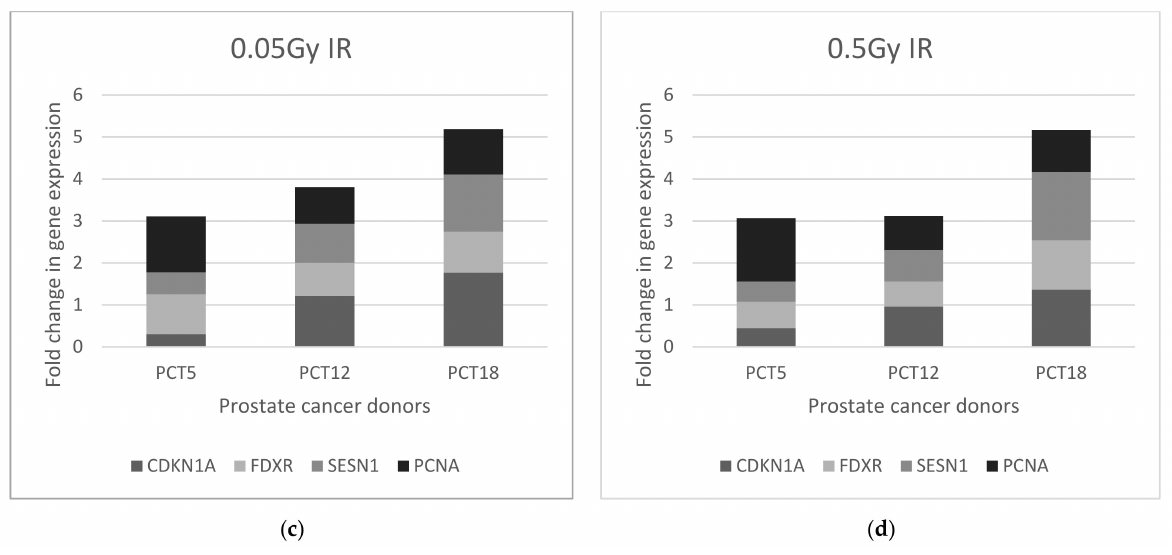
Figure 5. MQRTPCR fold change in gene expression for 4 target genes CDKN1A, FDXR, SESN1 and PCNA in prostate cancer donor samples taken at ( a ) Baseline exposed to 0.05 Gy, ( b ) Baseline exposed to 0.5 Gy; ( c ) ADT exposed to 0.05 Gy and ( d ) ADT exposed to 0.5 Gy. Baseline prostate donor samples coded PC ( n = 7) and ADT prostate donor samples code PCT ( n =